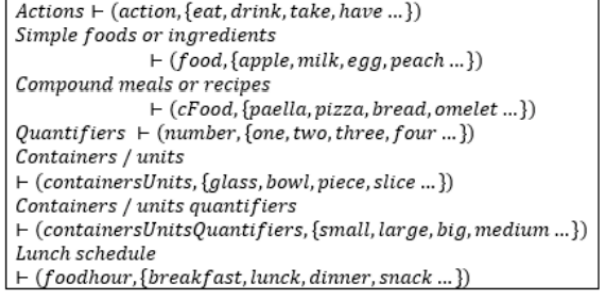
Figure 1. Entities for the semantic